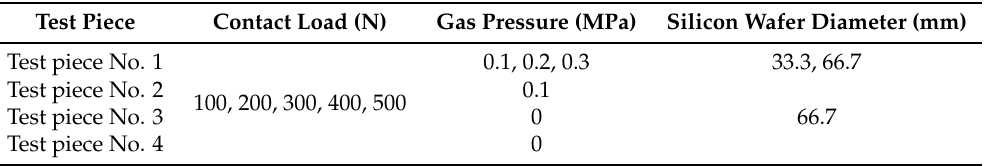
Table 2. Designed parameters for the contrast